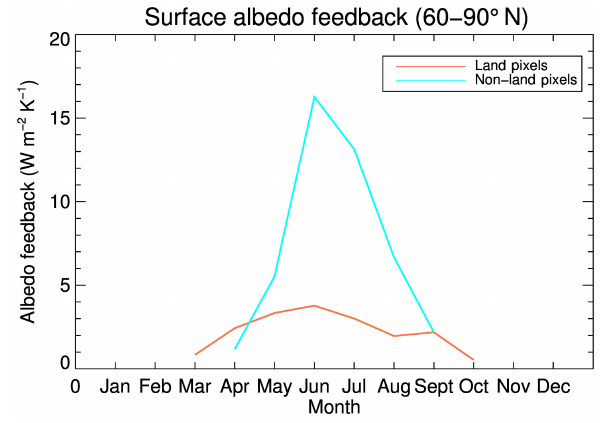
Figure 7. The snow–albedo and ice–albedo feedbacks (Eq. 1) for Arctic land (orange) and ocean (cyan) for the period